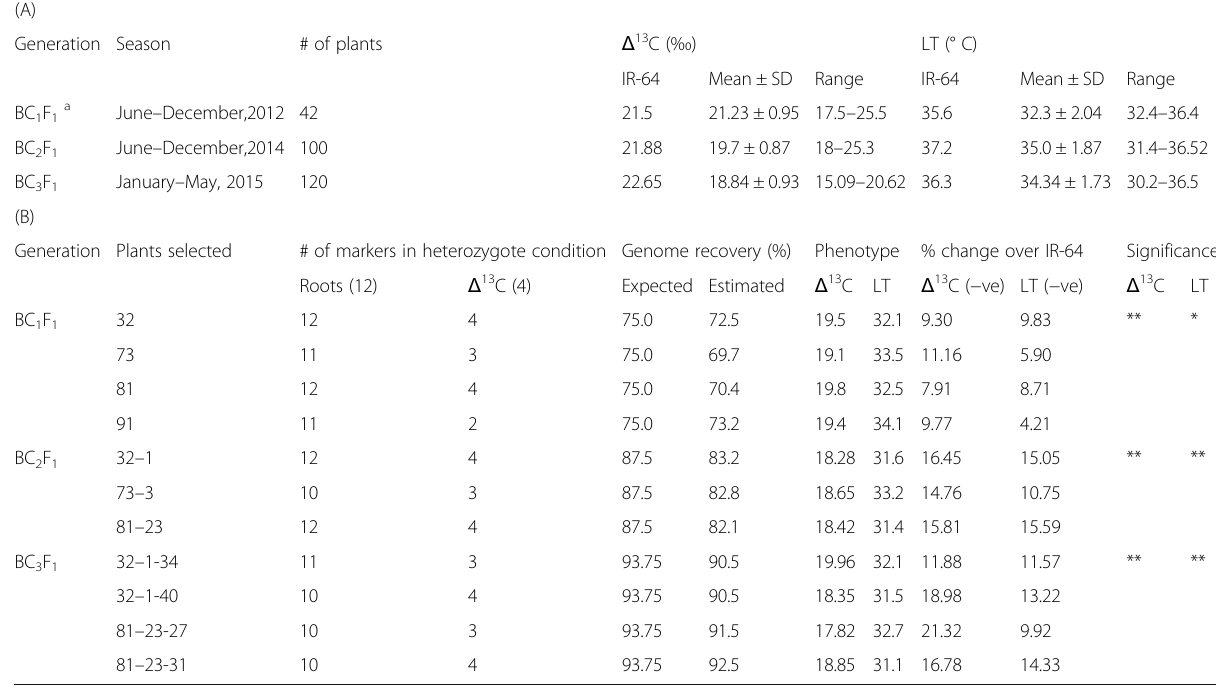
Table 3 Morpho-physiological and molecular variations of IR-64 and the backcross progenies at different generations (A) mean and range for the phenotypic value of target traits (B) improvement in traits over IR-64 at each generations, number of markers introgressed and background genome recovery in advanced backcross stages (A)